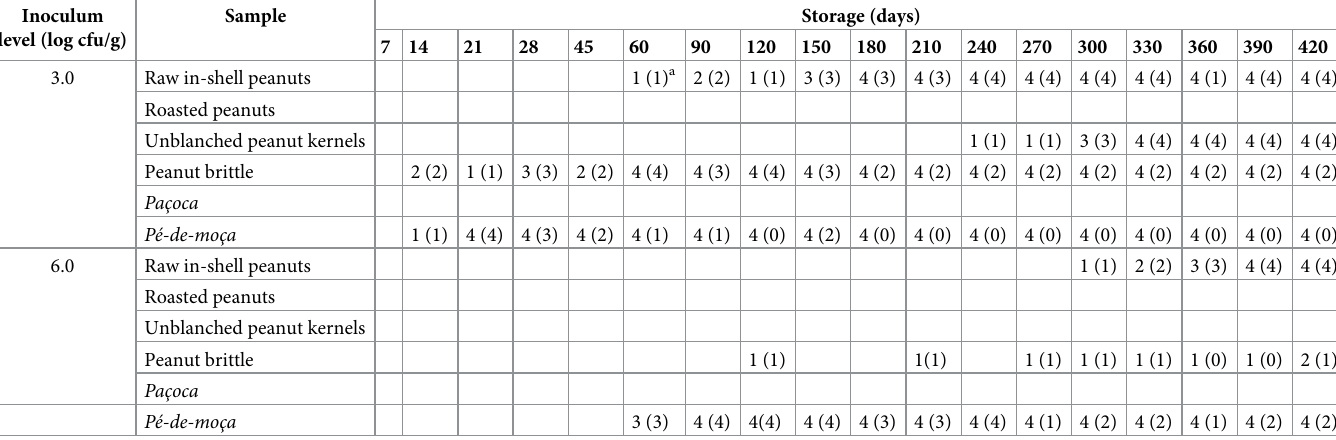
Table 1. Presence of Salmonella Typhimurium ATCC 14028 in peanut productswith counts below the limit of detection during a 420-days storage period at 28 ± 1˚ C. Inoculum level (log cfu/g)